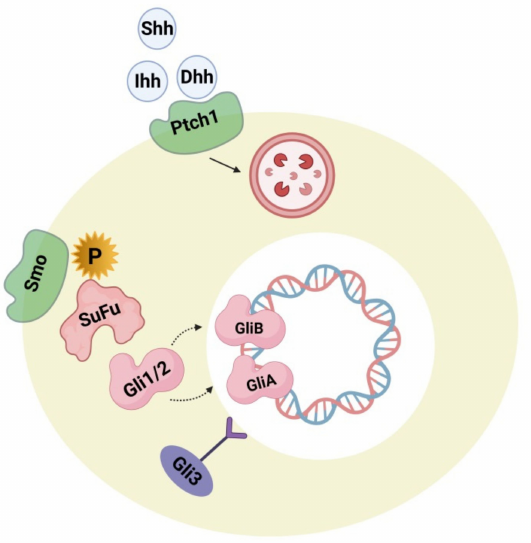
Figure 2. The hedgehog (hh) signaling pathway showing hh ligands (Shh, Dhh, Ihh) and their receptor Ptch 1. Upon binding with Ptch1, the pathway causes internalization, and Smo inhibition is released. After this, Smo is phosphorylated causing a cascade activation through downstream regulation, and Gli1/2 is processed into the activator forms GliA and GliB. After translocation of GliA into the nucleus, it stimulates target gene expression. The transcriptional repressor precursor Gli3 remains